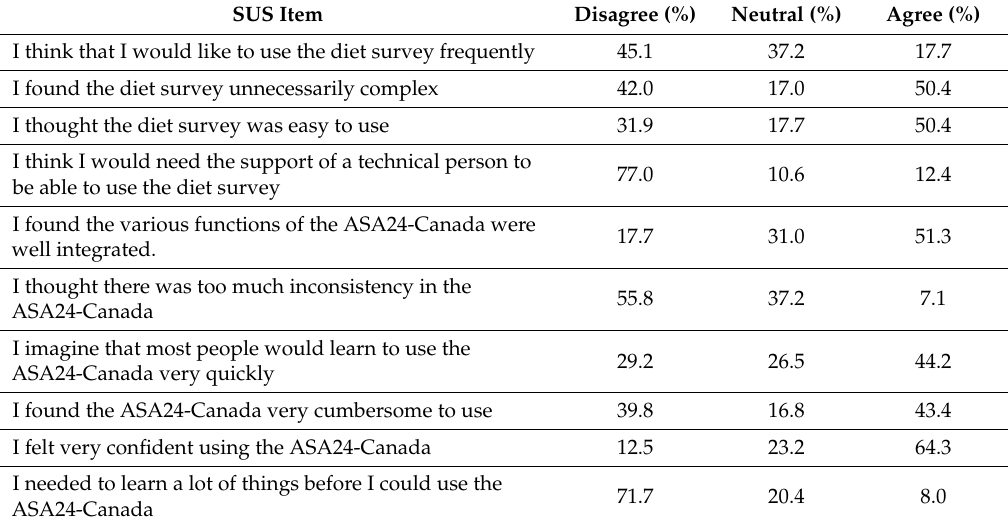
Table 5. Individual scores from the System Usability Scale (SUS) to evaluate the usability of ASA24, CLSA Diet Study ( n =